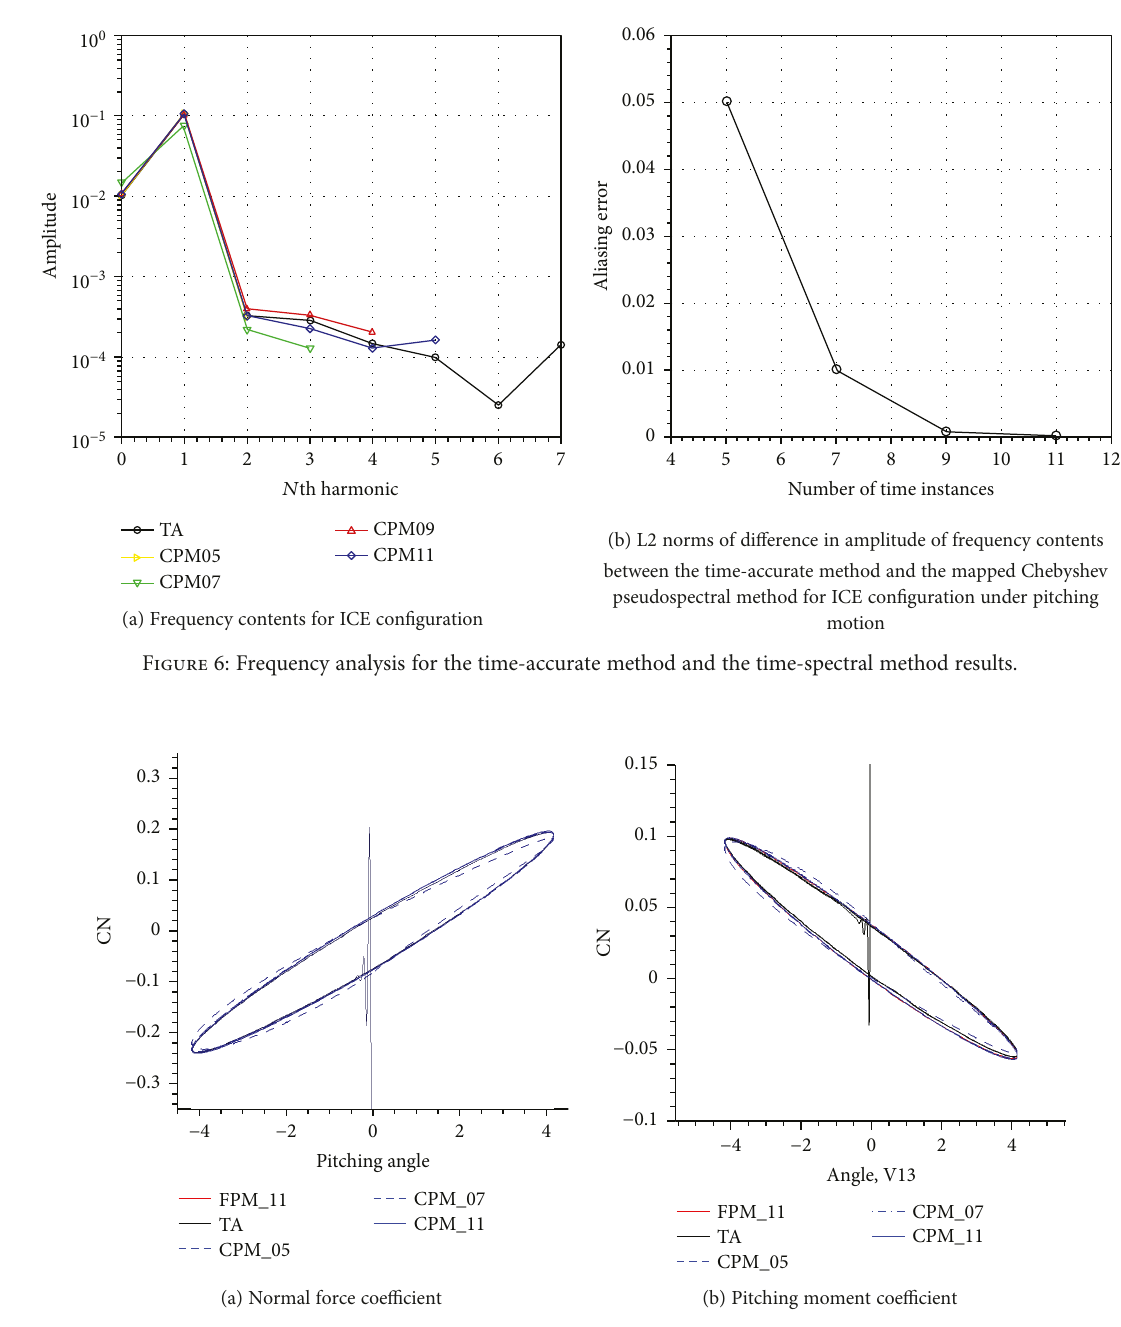
Figure 7: Normal force and pitching moment hysteresis of ICE con fi symbols in black and solid line with diamond symbols in red indicate the experimental data and the Fourier pseudospec- tral method results, respectively. The solid line in blue corre- sponds to the results from the present method. Figure 9